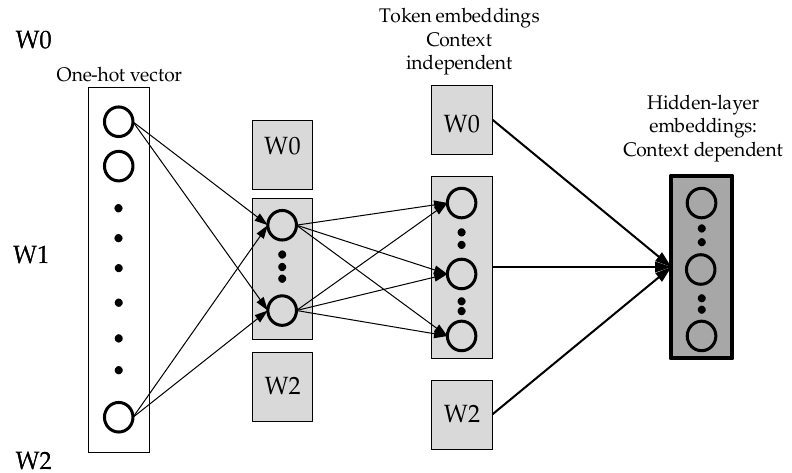
Figure 3. One-hot vector input of ALBERT.